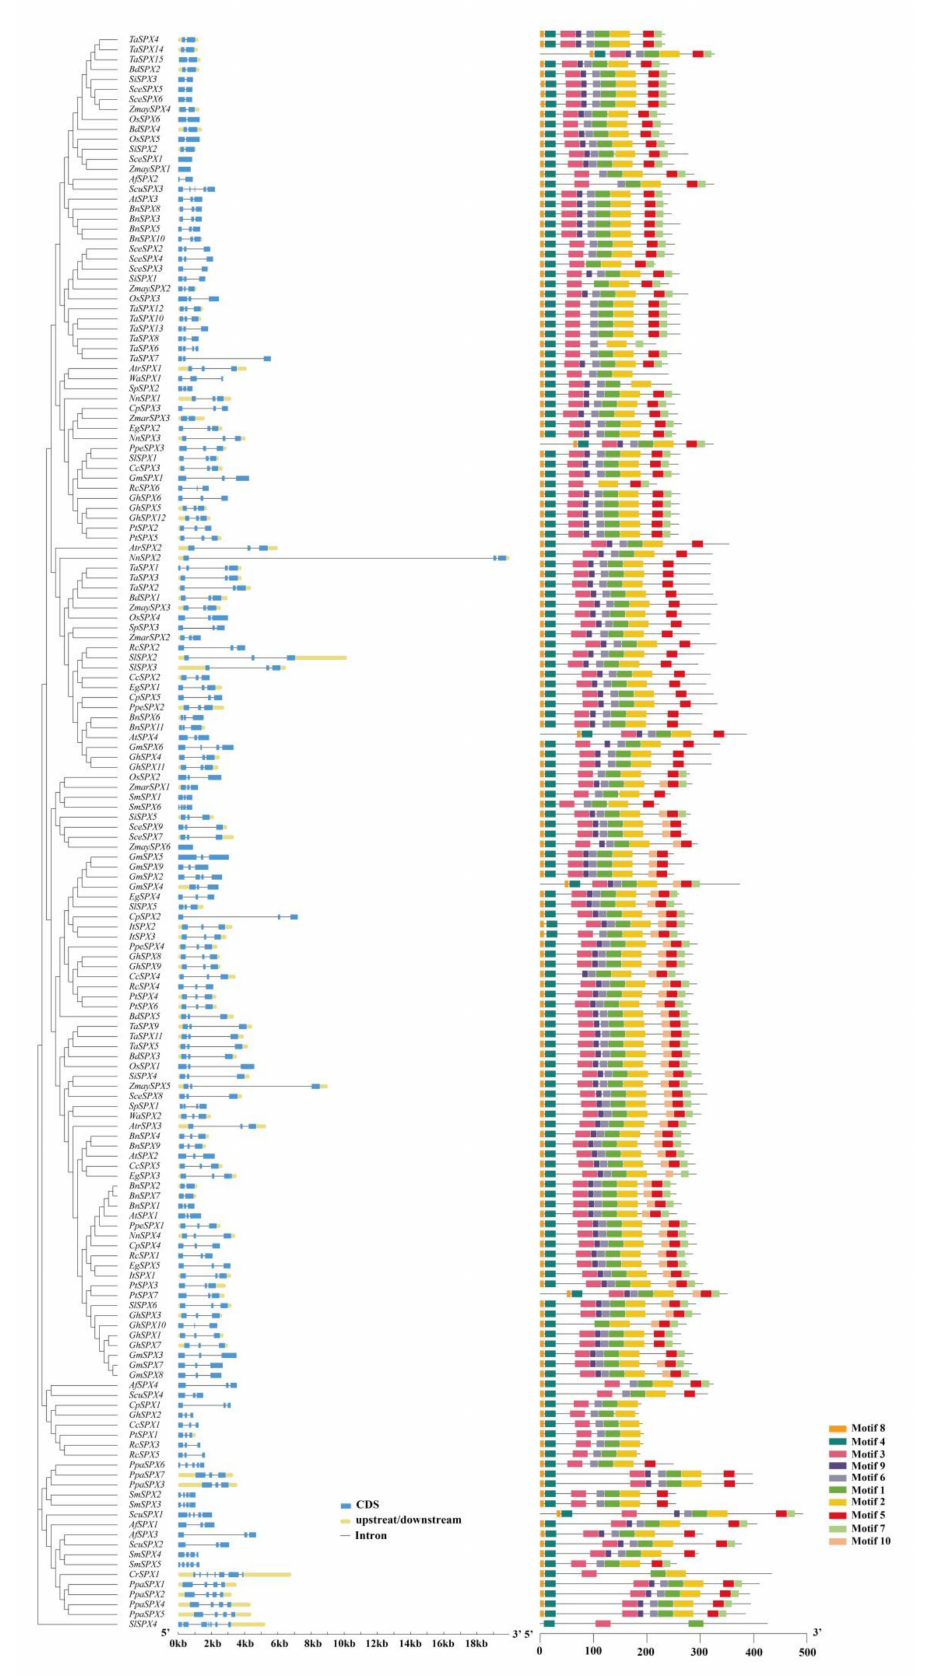
Figure 2. Cis -elements and conserved domain motifs in 160 SPX